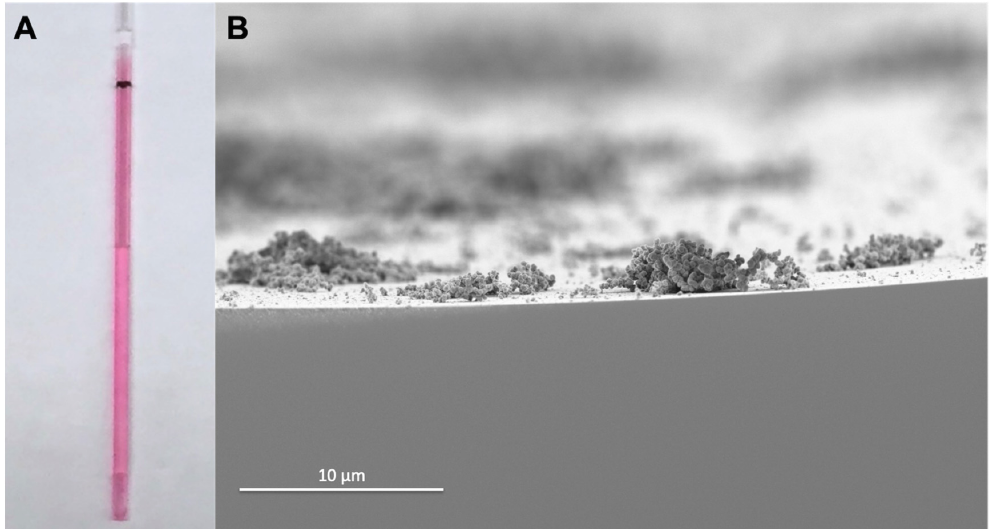
Figure 2. ( A ) Photograph of the capillary tube with no delay time and 1 min drying time at 3 liter per minute (LPM) airflow, loaded with R6G. ( B ) SEM of a capillary tube at 3000×, made using the same parameters, showing aggregates instead of a thin film.